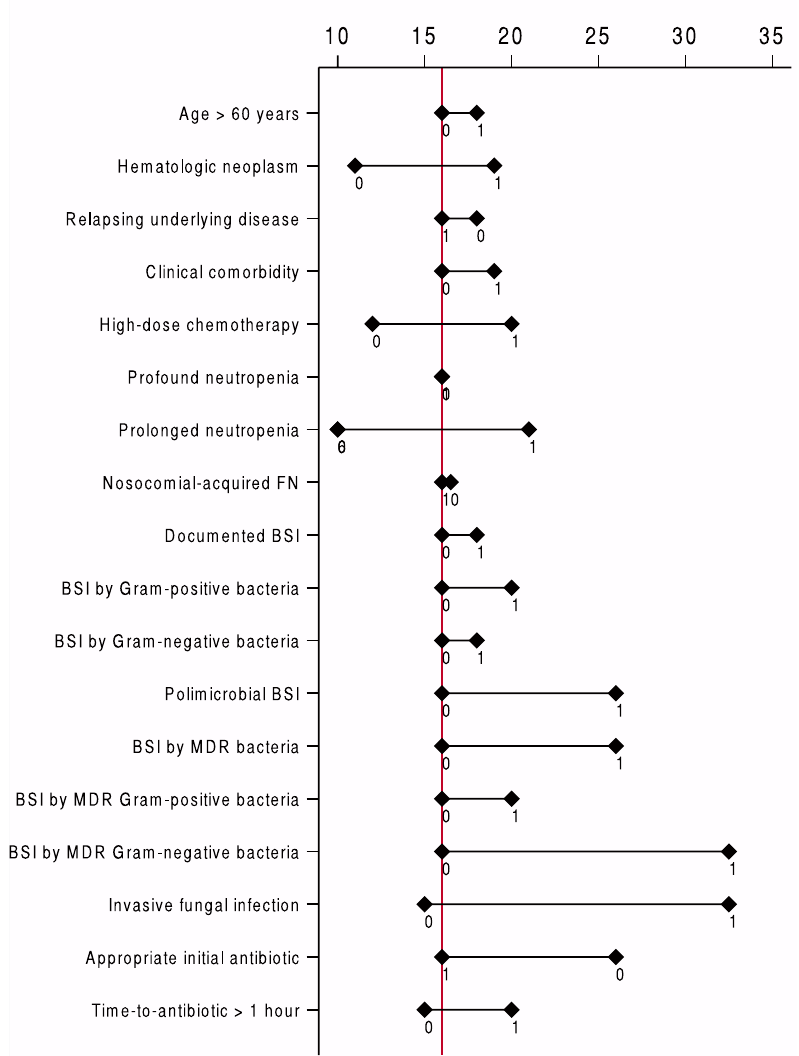
Figure 1. Median hospital length of stay among cases of febrile neutropenia according to clinical characteristics. The red line represents the median length of hospital stay of the entire cohort. For each variable, 1 and 0 represent, respectively, the median LOS for cases with and without the clinical characteristic described in the corresponding row; BSI = bloodstream infection; MDR = multi-drug-resistant.